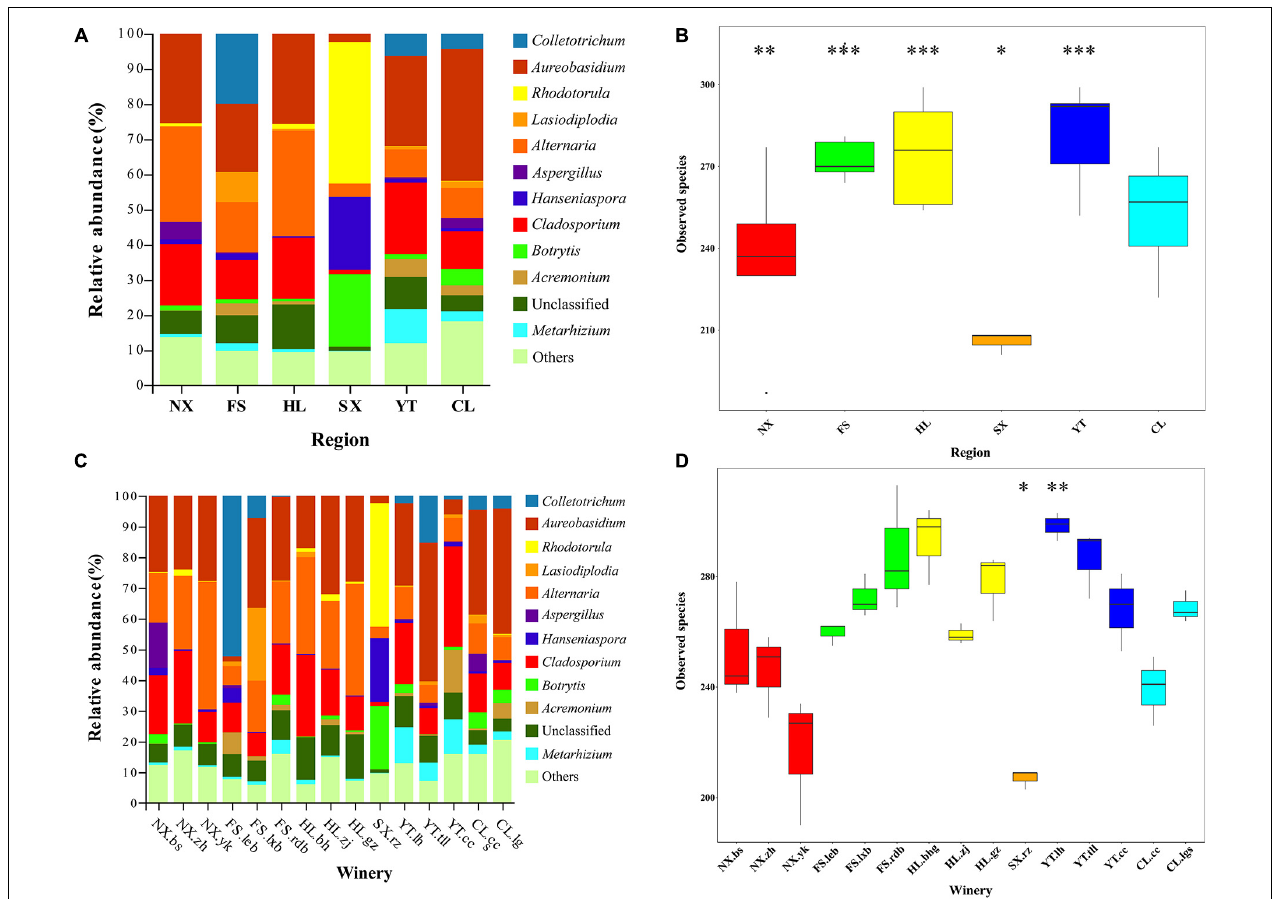
FIGURE 2 | Marselan must fungal communities. (A) Relative abundance percentages (%) of the Marselan must fungal genera from different regions. (B) Wilcoxon test involving the Marselan must fungal species numbers of different regions. (C) Relative abundance percentages (%) of the Marselan must fungal genera of different wineries. (D) Wilcoxon test involving the Marselan must fungal species numbers of different wineries. The symbols *, **, and *** represent significant